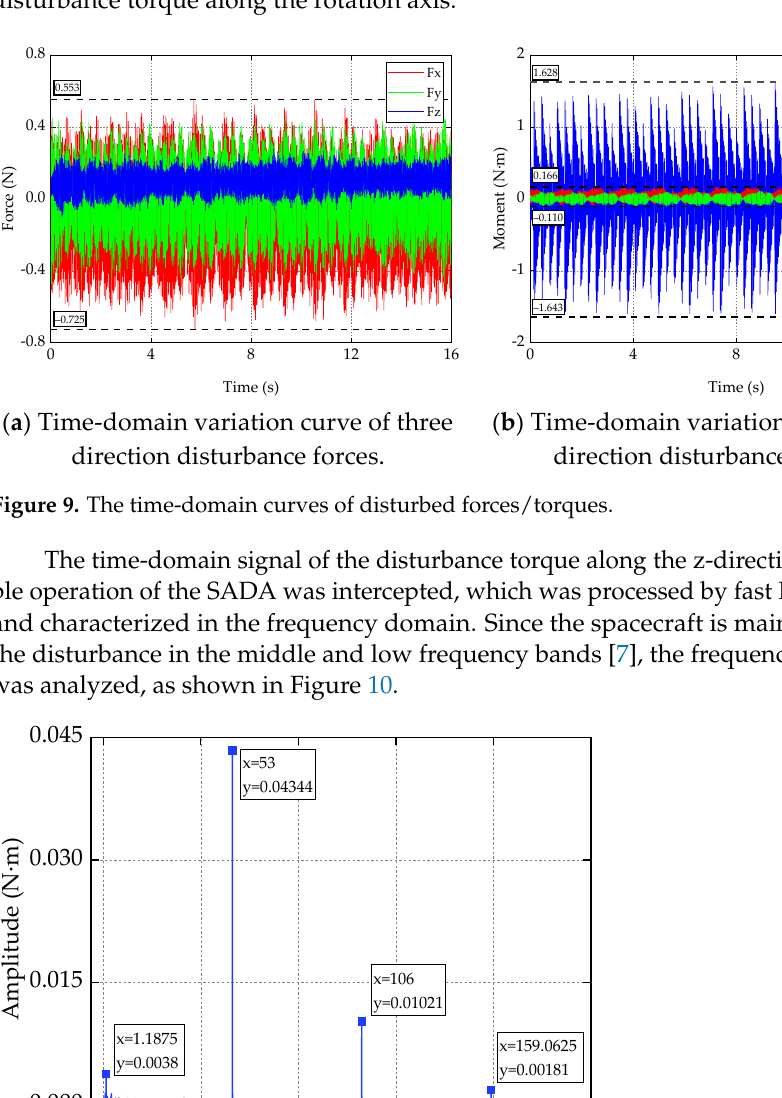
two categories: (1) The first-order torsional natural frequency of the solar array, which is 1.1875 Hz; (2) The motor-driving frequency and its high-order harmonics (53 Hz, 106 Hz, and 159 Hz, etc.). There are errors between the peak frequencies and the theoretical frequencies of 1.19 Hz and 53.33 Hz, which were caused by the frequency adjustment error of the SAS and the test system